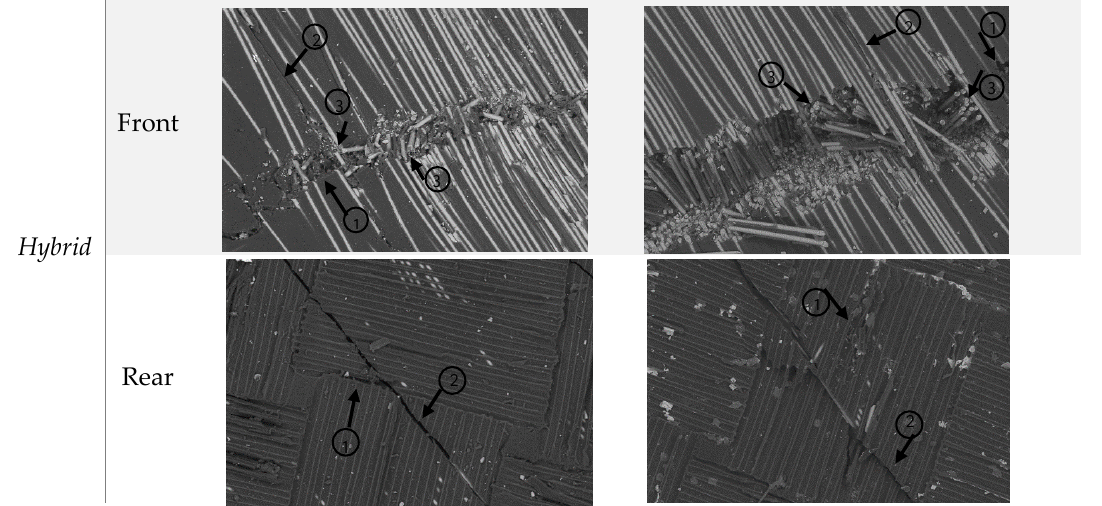
Figure 7. SEM pictures of dry and RT immersed glass fibre, flax fibre and hybrid composites with 300 × magnifications.